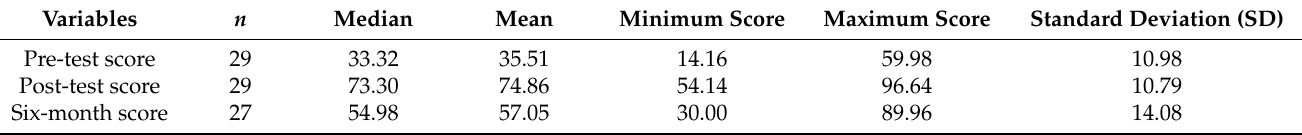
Table 2. First Aid Course Knowledge Scores.